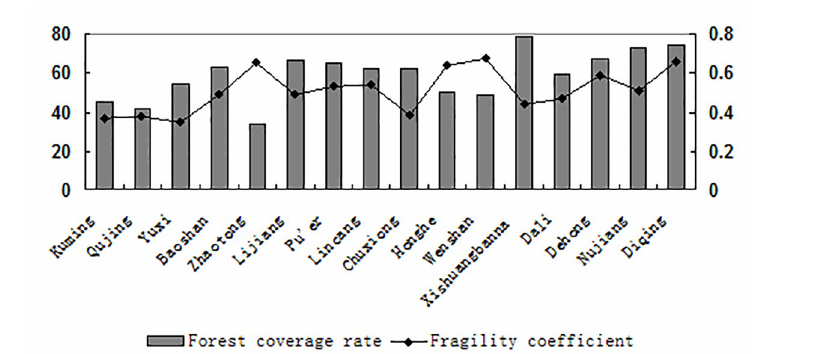
Fig 4. Forest coverage rate and fragility coefficient of Yunnan Province.